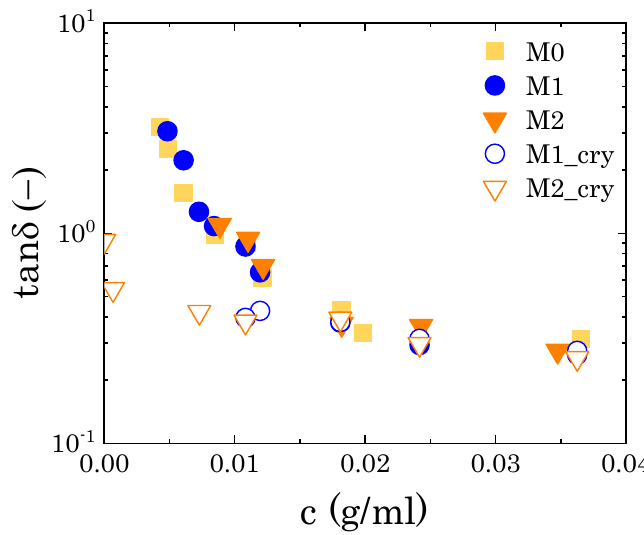
Figure 6. Loss tangent, sampled at 1 rad/s, as a function of Carbopol concentration for samples M0, M1, and M2. For the samples containing mannitol, closed symbols indicate regenerated samples, while open symbols indicate samples containing